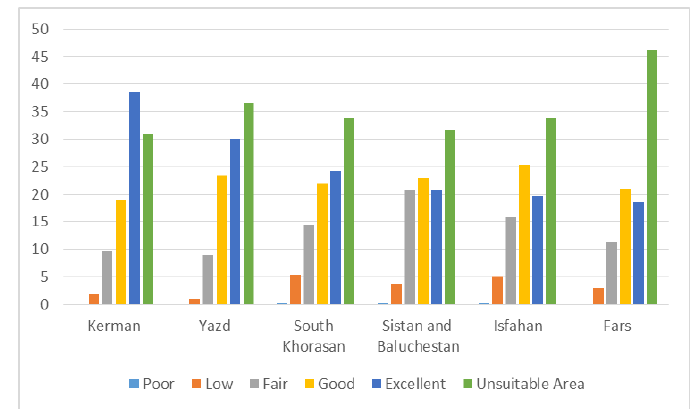
Figure 8. Area classification of the most suitable provinces.